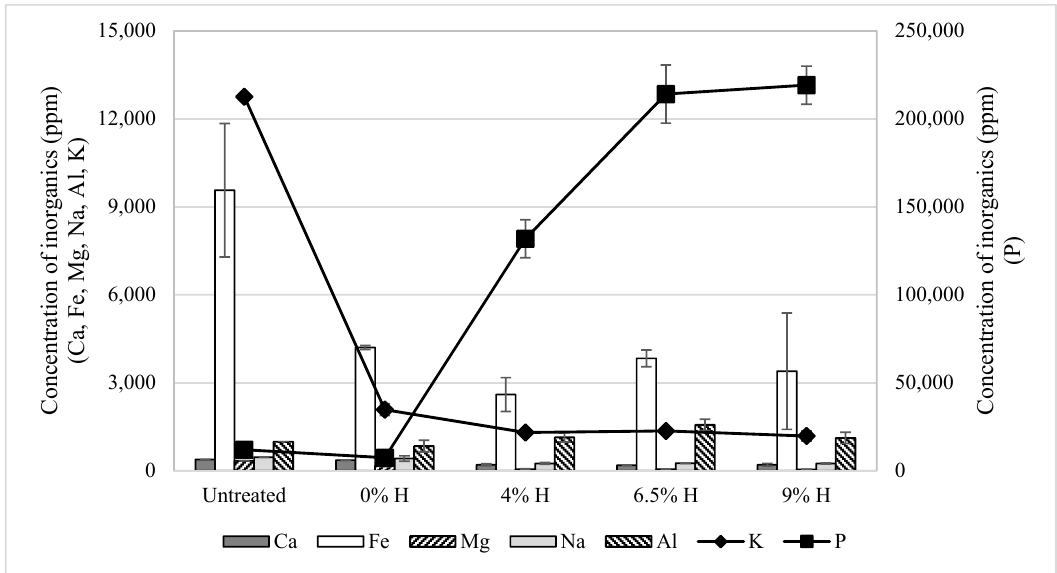
Figure 3. Elemental concentrations of selected inorganics with respect to the initial biomass mass for untreated and pretreated Phragmites australis , H: hydrolysis (H 3 PO 4 ).